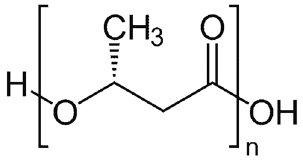
Figure 1. Chemical structure of poly-( R )-3-hydroxybutyrate (PHB).